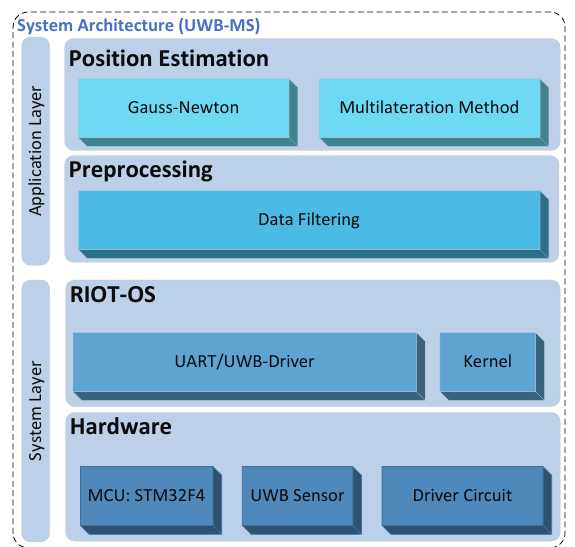
Figure 6. System architecture of a time of arrival-based MS.